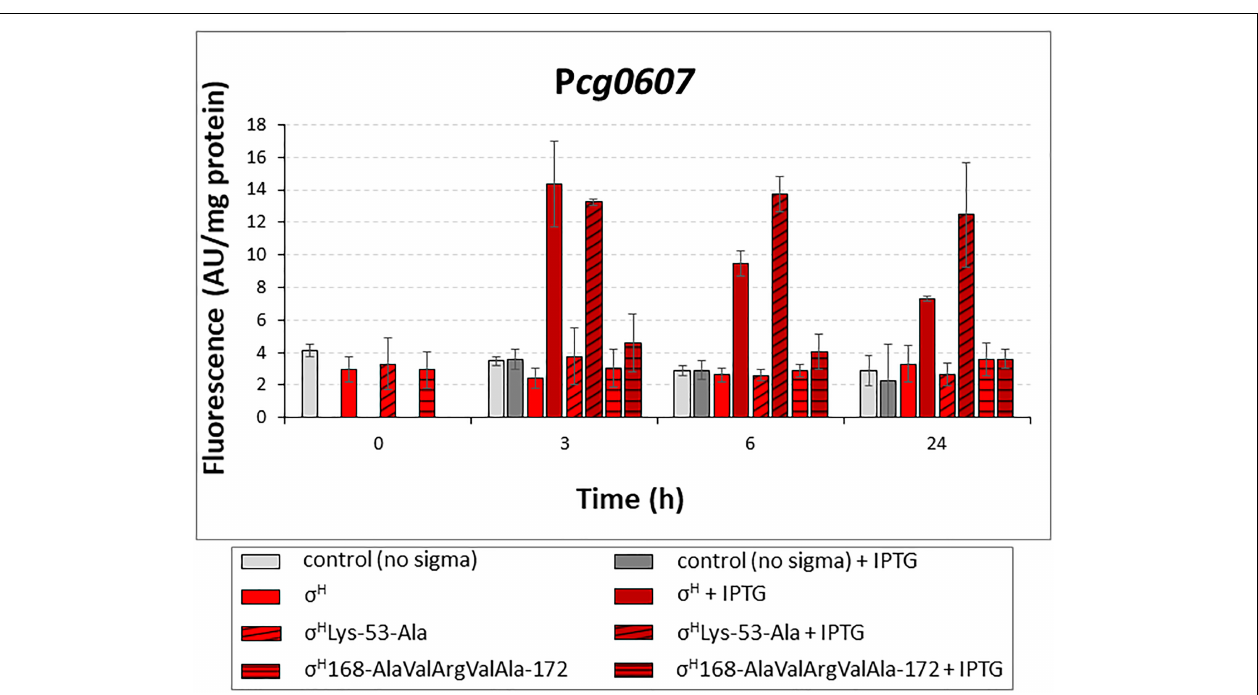
FIGURE 7 | Determination of promoter activity in C. glutamicum WT with overexpressed sigH or its mutants σ H Lys-53-Ala and σ H 168-AlaValArgValAla-172 by using two-plasmid assay. The C. glutamicum strains carried the vector pEC-XT99A overexpressing sigH (open bars), σ H Lys-53-Ala (cross-hatched bars) or σ H 168-AlaValArgValAla-172 (horizontally hatched bars) after IPTG addition and the promoter-test vector pEPR1 with the target promoter P cg0607 . The strain with the empty expression vector pEC-XT99A was used as a control (gray bars). The promoter activity was measured as the Gfpuv fluorescence intensity of the cell extracts. Fluorescence of cultures without IPTG is shown as light bars; fluorescence of cultures with IPTG induction is shown as dark bars. AU, arbitrary units. The standard deviations of three biological replicates are depicted by error